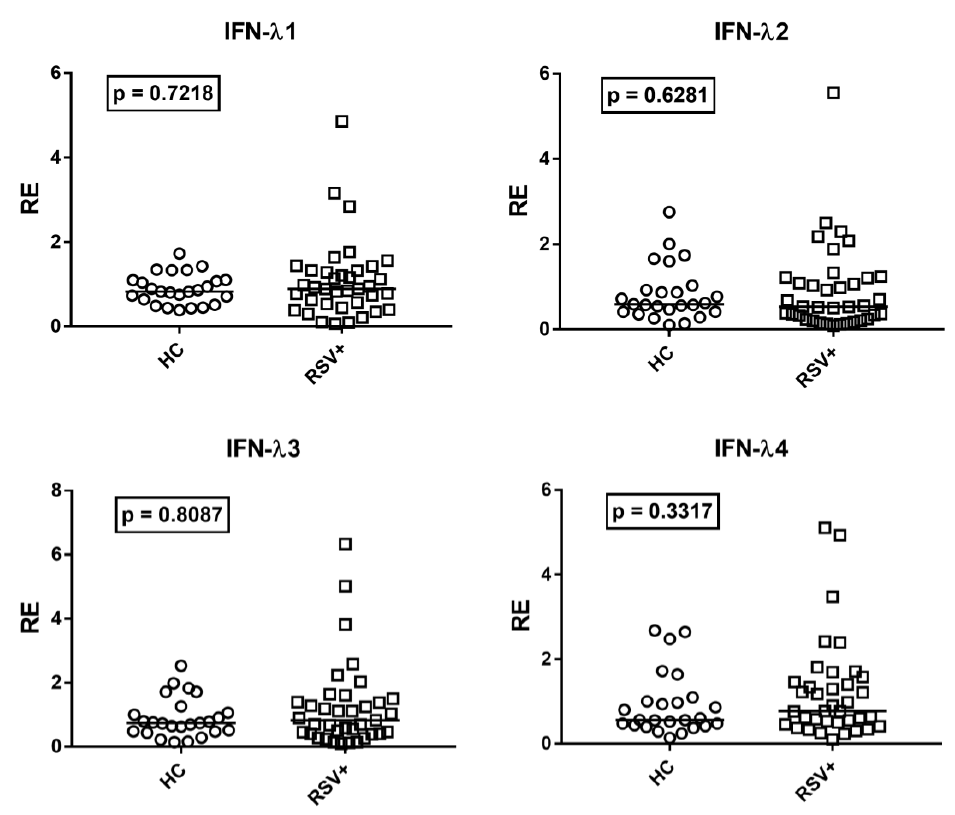
Figure 4. Expression of type III interferons in whole blood from 37 children with acute RSV bronchiolitis (RSV+) and 25 age-matched healthy children (HC). RE: relative expression. Circles and squares show the mean of three individual measurements; horizontal lines show the median values. Median values and interquartile range 25–75% of IFN-IIIs: IFN- λ 1: HC 0.83, 0.64–1.10; RSV+ 0.89, 0.53–1.32; IFN- λ 2: HC 0.59, 0.42–0.93; RSV+ 0.54, 0.25–1.21; IFN λ 3: HC 0.74, 0.48–1.06; RSV+ 0.83, 0.41 – 1.39; IFN 4: HC 0.56, 0.44 – 1.00; RSV+ 0.77, 0.50 – 1.46. Statistical analysis: Mann – Whitney